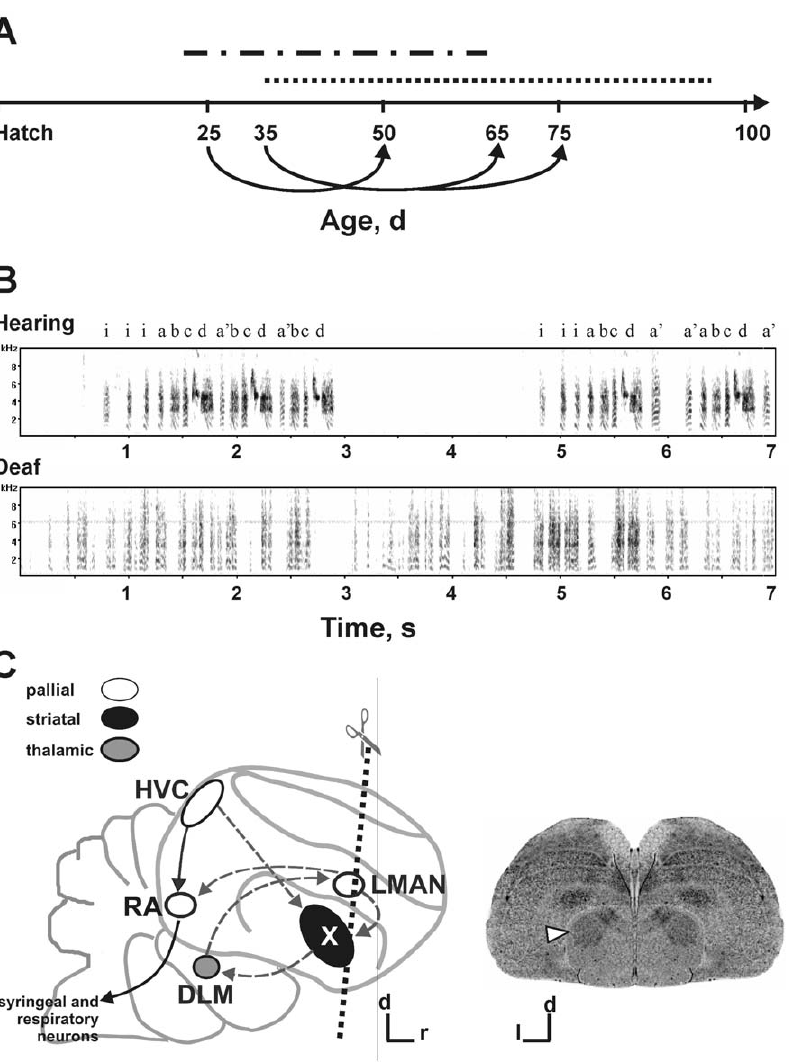
Figure 1. Deafening at 35d causes abnormal song development. A ) Time line for experiments conducted during song learning which ends at , 90d. One group of birds was either untreated, sham-operated or deafened at 25d, during sensory acquisition (dashed and dotted line) and prior to the onset of sensorimotor learning (dotted line). Their FoxP 2 levels were measured at 50d. Another group of birds was either untreated or deafened at 35d, the onset of sensorimotor learning, and their FoxP2 levels measured at either 65 or 75d. B ) Exemplar spectrograms of a 75d hearing (top) and a deaf (bottom) bird. Although yet immature, the 75d hearing bird’s song shows structures typical of zebra finch songs including introductory notes (i) and repeated motifs, which are composed of 4–7 easily identified syllables (a or a’ – d). In contrast, songs of 75d deafened males were disrupted, and motifs were not identifiable. Signal at , 6.5 kHz represents background noise. C ) Left - schematic of major nuclei of the song circuit indicates the plane of section used to examine FoxP2 levels in area X (arrowhead in the Nissl stain; right). Abbreviations: d – dorsal, DLM – medial portion of the dorsolateral nucleus of the anterior thalamus, HVC – acronym used as a proper name, l – lateral, LMAN – lateral magnocellular nucleus of the anterior nidopallium, r – rostral, RA – robust nucleus of the arcopallium, X – area X of the medial striatum. Axis lines underneath the Nissl section (right) indicate 1mm.